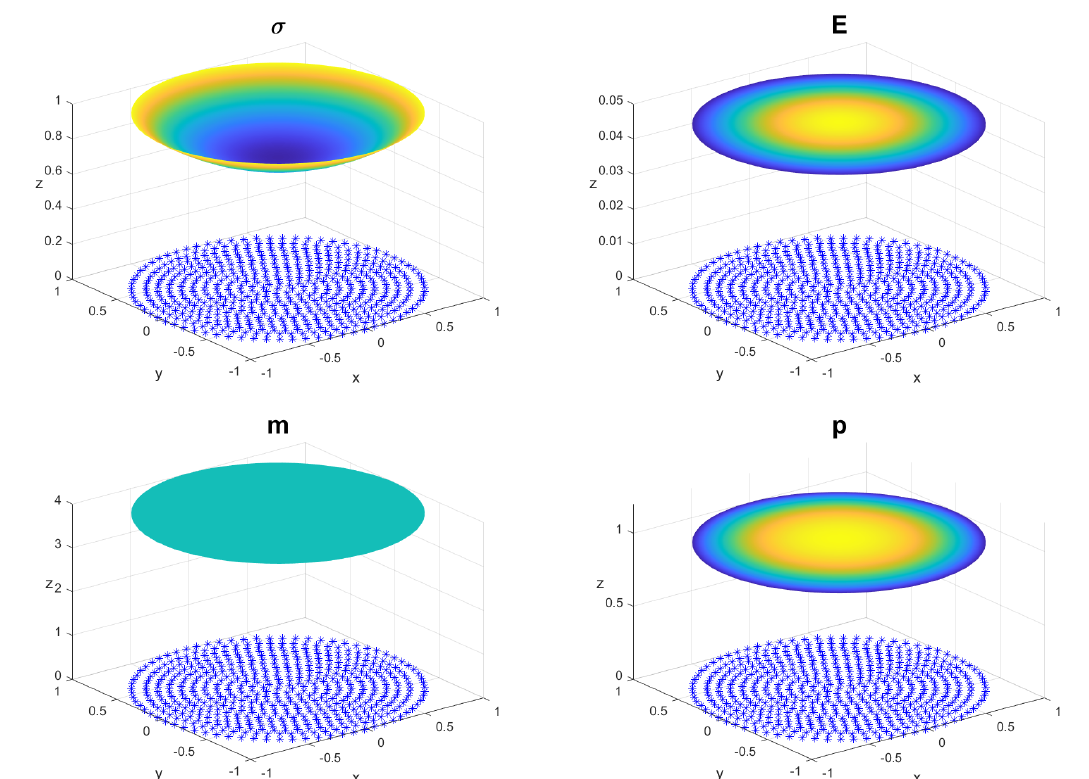
Figure 5. Graphs of the functions: σ , E , m and p for t = 2